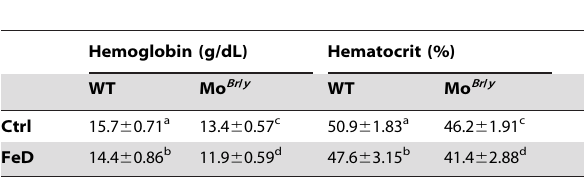
Table 1. Analysis of blood collected from WT and Brindled mice consuming control (Ctrl) and iron-deficient (FeD) diets.